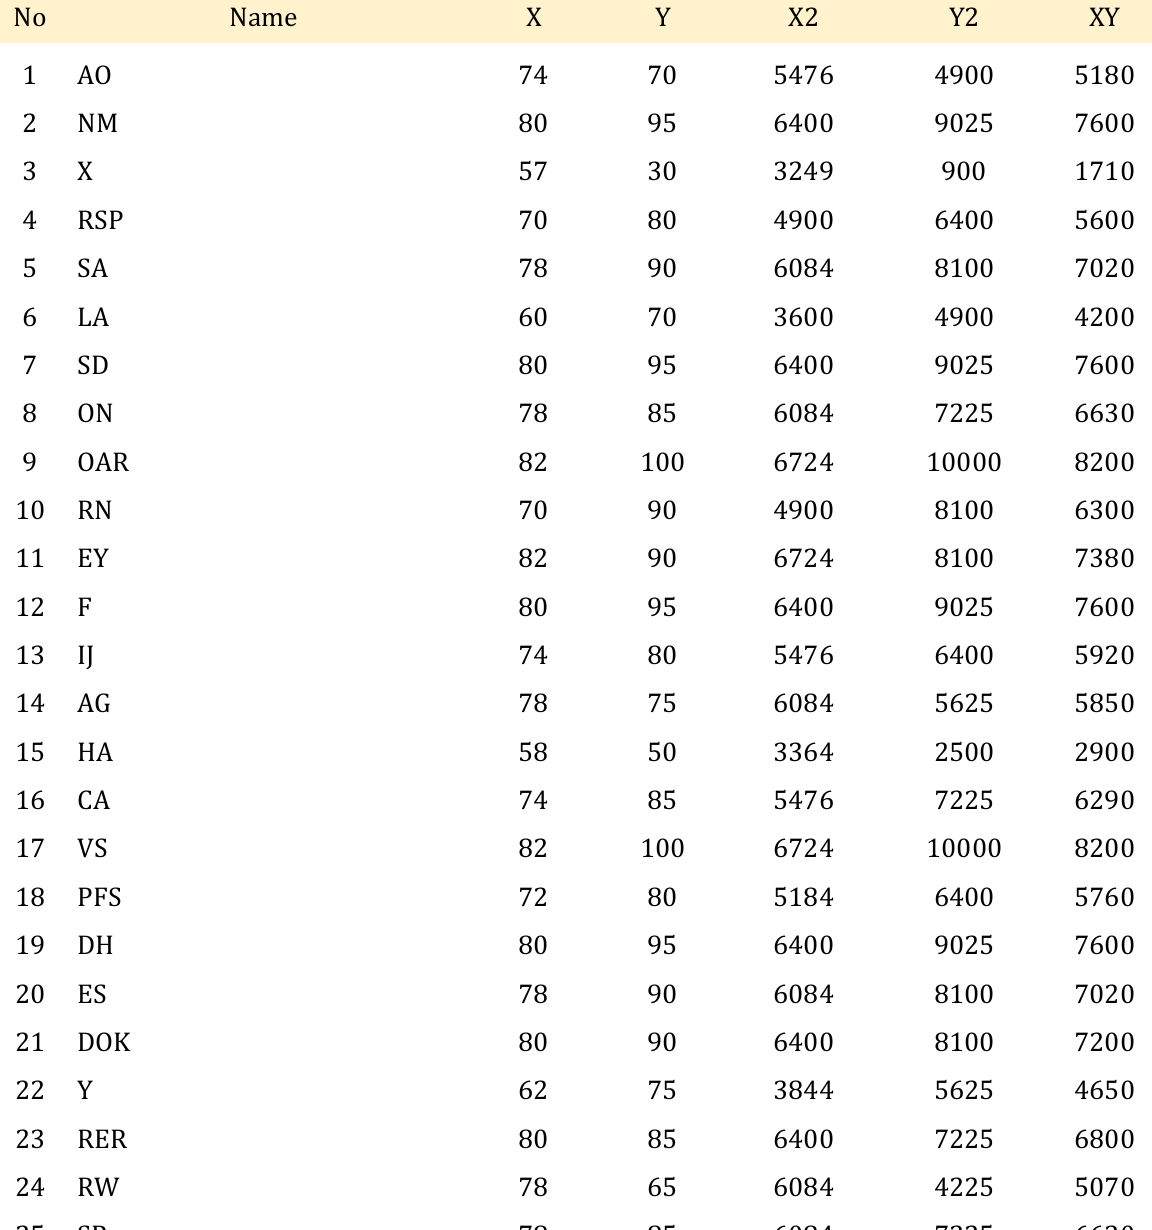
Table 5. The Result of Coefficient